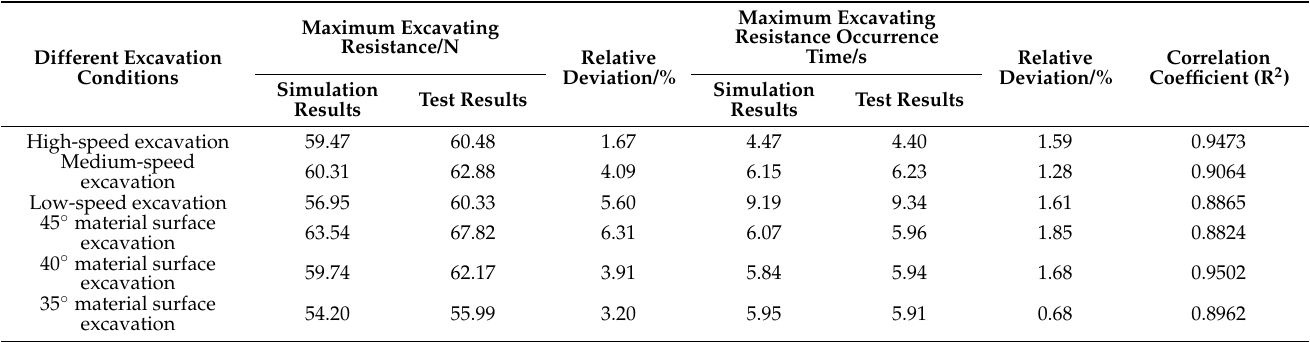
Table 7. Comparison between simulation and experimental data under different working